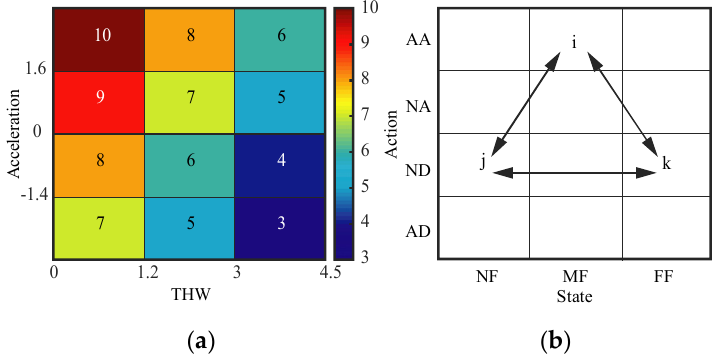
Figure 9. The driving behavior semantic plane. ( a ) driving risk evaluation model, ( b ) the State–Action semantic plane.